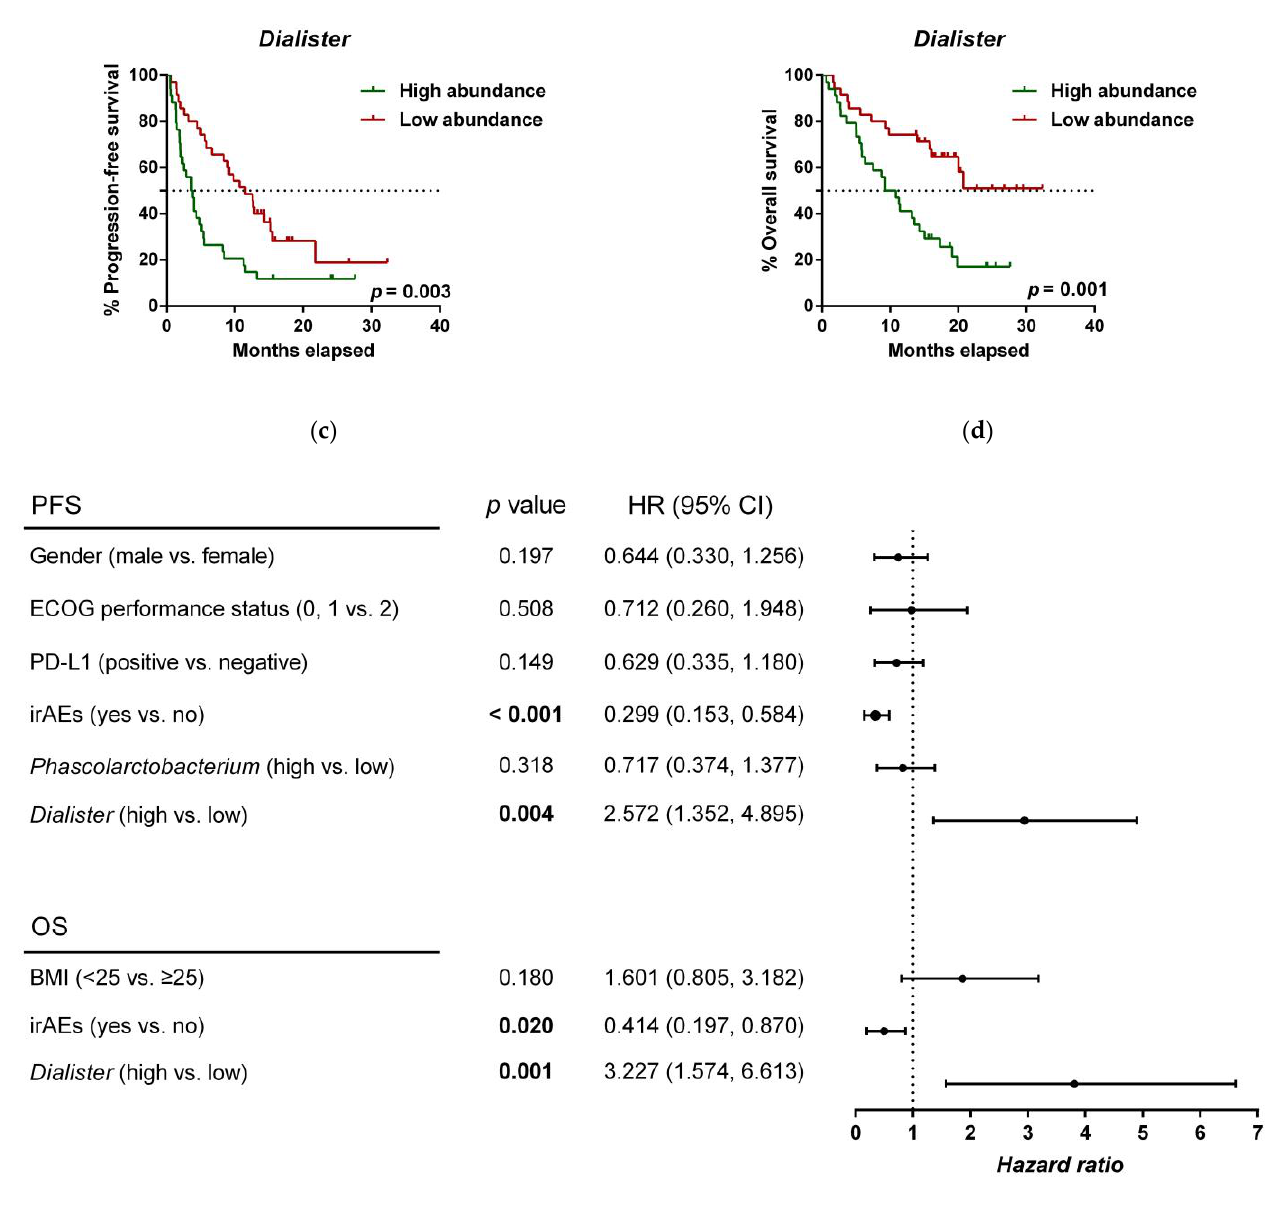
Figure 5. Dialister abundance and the presence of irAEs are independent prognostic factors for PFS and OS. ( a ) Kaplan–Meier plot of PFS in patients with high (green line, n = 35 (CB = 22, PD = 13), median PFS = 9.8 months) or low abundance of Phascolarctobacterium (red line, n = 34 (CB = 11, PD = 23), median PFS =3.8 months). ( b ) Kaplan–Meier plot of OS in patients with high (green line, n = 35 (CB = 22, PD = 13), median PFS = 19.9 months) or low abundance of Phascolarctobacterium (red line, n = 34 (CB = 11, PD = 23), median PFS = 11.4 months). ( c ) Kaplan–Meier plot of PFS in patients with high (green line, n = 34 (CB = 9, PD = 25), median PFS = 3.6 months) or low abundance of Dialister (red line, n = 35 (CB = 24, PD = 11), median PFS = 11.5 months). ( d ) Kaplan–Meier plot of OS in patients with high (green line, n = 34 (CB = 9, PD = 25), median PFS = 9.3 months) or low abundance of Dialister (red line, n = 35 (CB = 24, PD = 11), median PFS = not reached months). ( e ) Forest plot illustrating the results of multivariate analysis by the Cox proportional-hazard model. Statistical analysis was performed using the log-rank test. Bold p -values denote statistical significance at the p < 0.05 level. Cutoff values correspond to the median relative abundance: 1.92% ( Phascolarctobacterium ), 0.01% ( Dialister ). ECOG: Eastern cooperative oncology group; irAEs: immune-related adverse events; BMI: body mass index; PFS: progression-free survival; OS: overall survival; HR: hazard ratio; CI: confidence interval.